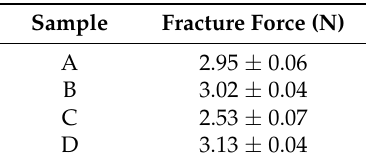
Table 8. Mean values of the fracture forces of SA products based on 20 measurements.